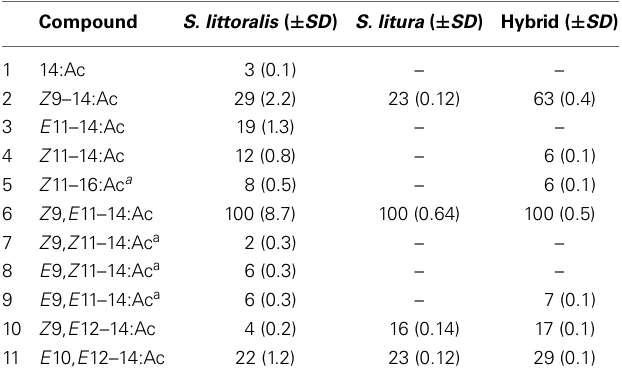
Table 1 | Pheromone gland composition according to GC-MS analysis. Compound